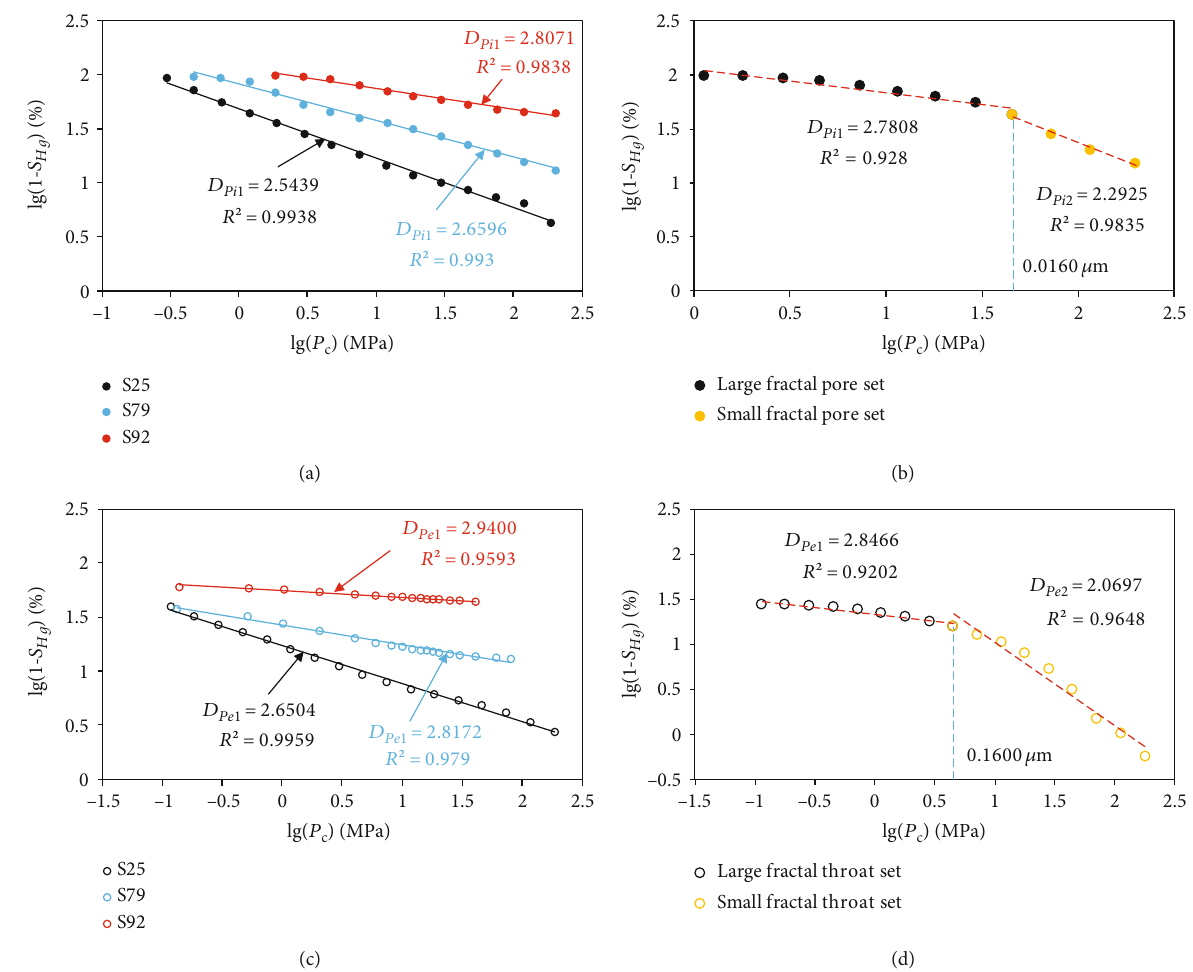
Figure 4: Double logarithmic plots of wetting phase saturation versus capillary pressure from PCMI experiments: type I of (a) intrusion and (c) extrusion branches from three typical specimens; type II of (b) intrusion and (d) extrusion branches from S22 and S95, respectively. D fractal dimension values from intrusion branches of PCMI tests or large fractal pore set; D values from extrusion branches of PCMI tests or large fractal throat set; D